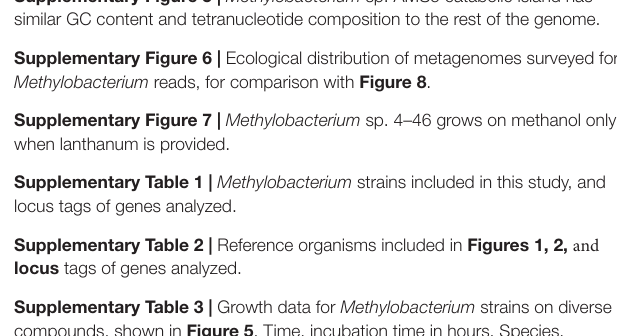
Supplementary Table 6 | Summary of metagenomes surveyed for Methylobacterium vanA ( Figure 7 ). Supplementary Table 7 | All metagenomes in which Methylobacterium vanA genes (shown in Figure 7 ) were found. Supplementary Table 8 | All metagenome scaffolds containing vanA genes and identified as Methylobacterium , shown in Figure 7 . Supplementary Table 9 | Metagenomes surveyed for BLAST hits to each of 18 Methylobacteriaceae query genomes.